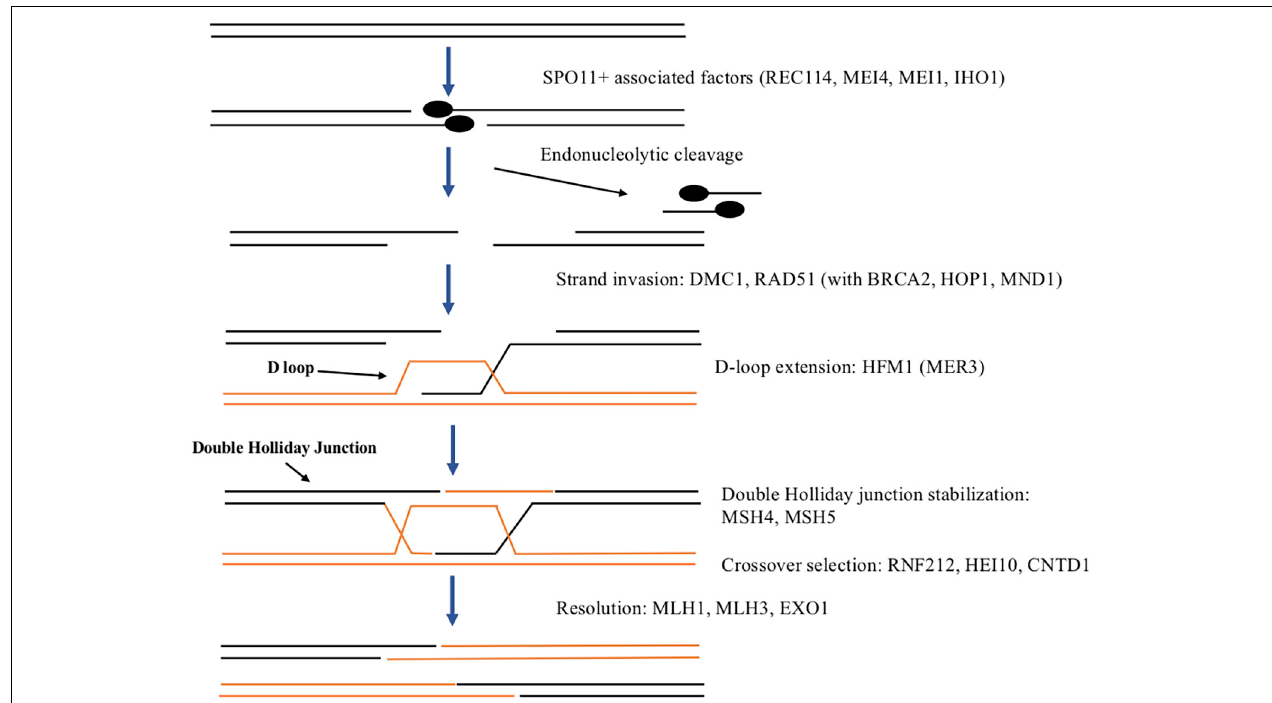
FIGURE 2 | Summary of DSB formation and repair in mammals. SPO11 and associated factors including REC114, MEI4, MEI1, and IHO1 generate a double strand break to initiate recombination. Endonuclease activity results in cleavage of a small DNA fragment associated with SPO11. The resulting single-stranded DNA overhang is extended on both DNA strands by exonuclease activity. RAD51 and DMC1 along with other proteins aid in strand invasion of the homologous chromosome to begin the process of homologous recombination to repair the DSB. This forms the D-loop on the homolog that is extended by HFM1. If the other side of the DSB is “captured” a double Holliday junction is formed and stabilized by MSH4 and MSH5. This can either resolve to a crossover or a non-crossover with RNF212, HEI10, and CNTD1 involved in regulating crossover selection. Resolution to the final crossover products is promoted by MLH1, MLH3, and